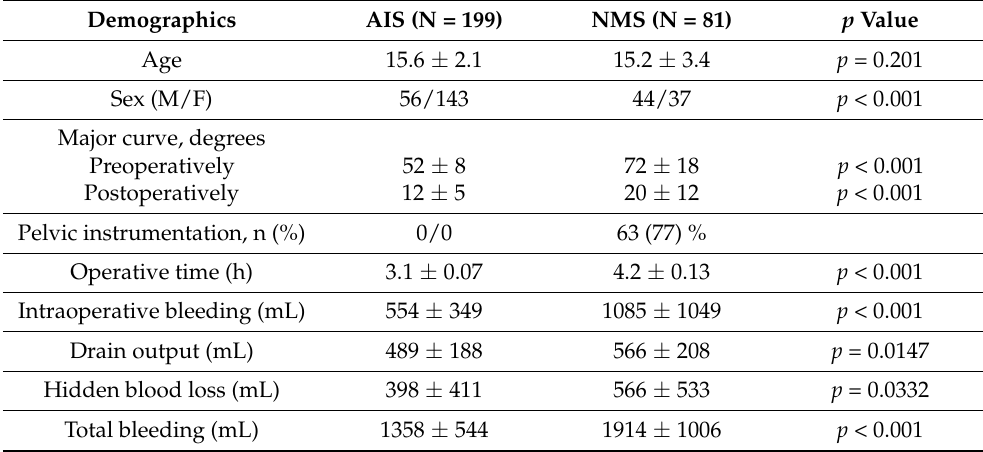
Table 1. Patient demographics [16].